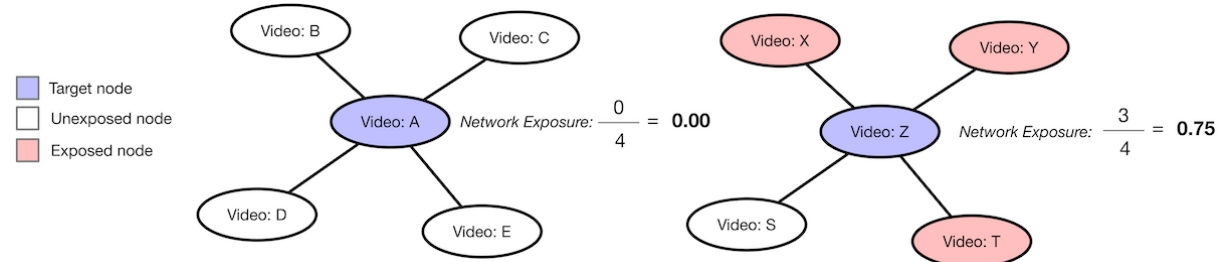
Figure 1. Network exposure model example showing two nodes (A and Z) exposed to attributes based on their ties. The example was adapted from Valente